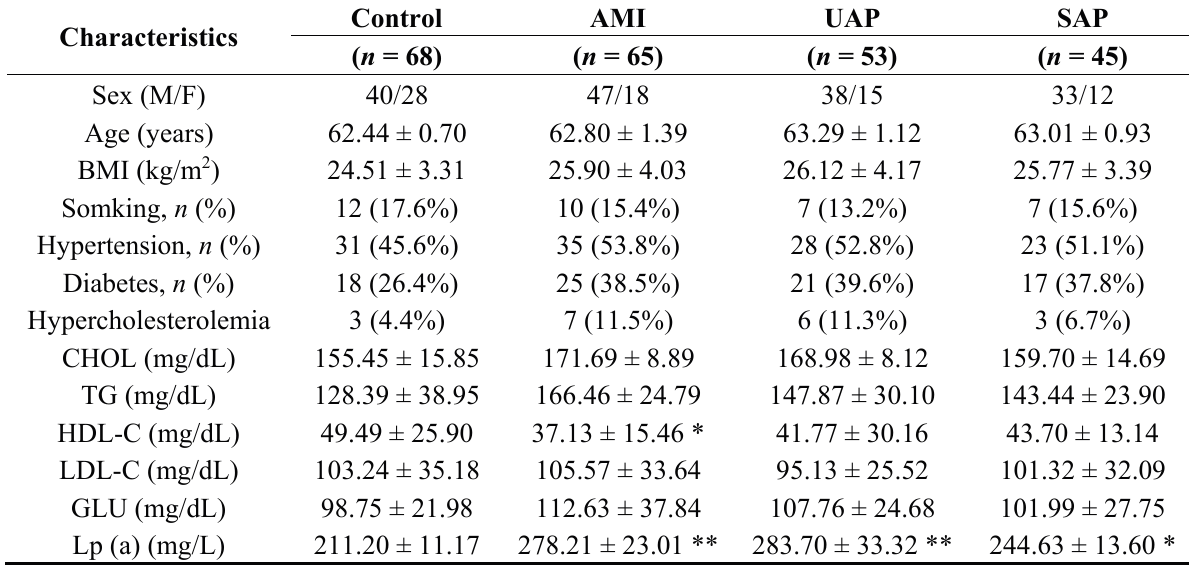
Table 1. Characteristics of coronary artery disease (CAD) cases and the control